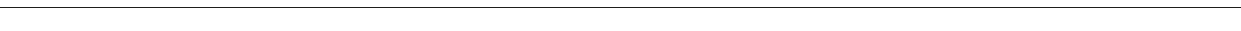
Fig. 3 Schwann cell morphology during early regeneration is disrupted in lrp4 mutants. a Pre-transection 5 dpf, GFP-labeled sibling nerve stained with anti- Sox10 antibody labeling Schwann cell nuclei (magenta). Yellow arrowheads mark Schwann cell nuclei; scale bar 10 µ m. b Sibling nerve 48 hpt labeled with GFP and stained with anti-Sox10 antibody. Yellow arrowheads mark Schwann cell nuclei. c Quanti fi cation of Schwann cell nuclei along individual nerves pre-transection and 48 hpt in siblings and lrp4 mutants. Pre-transection average Schwann cell number in siblings = 11.9 per nerve, n = 16 nerves; average Schwann cell number in lrp4 mutants = 10.78 per nerve, n = 36 nerves (two-tailed t -test p = 0.08, t = 1.743, df = 50; error bars denote mean and SD). Average Schwann cell number 48 hpt in siblings = 8.3 per nerve, n = 6 nerves; average Schwann cell number 48 hpt in lrp4 mutants = 9.3 per nerve, n = 6 nerves (two-tailed t -test p = 0.59, t = 0.5459, df = 10; error bars denote mean and SD). d – k Images from time lapse movies showing early regeneration dynamics in sibling ( d – g ) and lrp4 mutant ( h – k ) nerves. Motor axons express GFP, Schwann cells express mRFP (magenta). d Pre-transection sibling nerve, yellow box marks transection site. Schwann cell membranes (yellow arrowheads) are thin and closely associate with motor axons. White box indicates region magni fi ed in ( e – f ). Scale bar 10 µ m. e Magni fi ed image showing granular Schwann cell morphology characteristic of a denervated Schwann cell (yellow arrowheads). f Schwann cell membranes revert to smooth pre-injury morphology (yellow arrowheads). Yellow box marks region magni fi ed in (g ). g Magni fi ed image at same timepoint as ( f ), showing regenerating axons (green arrowheads) associating with fl attened Schwann cell membranes (yellow arrowheads; n = 4/4 nerves). h Pre-transection lrp4 mutant nerve, yellow box marks transection site. Schwann cell membranes (yellow arrowheads) look wild type. White box indicates region magni fi ed in ( i – j ). i Magni fi ed image showing granular Schwann cell morphology (yellow arrowheads). j Lrp4 mutant Schwann cell membranes fail to revert to smooth pre-injury morphology (yellow arrowheads). Yellow box marks region magni fi ed in ( k ). k Magni fi ed image at same timepoint as j , showing a regenerating axon (green arrowhead) associating with granular Schwann cell membranes (yellow arrowheads; n = 7/8 nerves). l Pre-transection sibling nerve; yellow box marks transection site. m – o By 48 hpt, Schwann cell membranes form two thin, continuous tracks along which regenerating axons grow; white box indicates region magni fi ed in n – o ( fi lled yellow arrowheads mark Schwann cell membranes, green arrowheads mark regenerating axons; n = 23/24 nerves). p Pre-transection lrp4 mutant nerve; yellow box marks transection site. q – s By 48 hpt, Schwann cell membranes fail to form two thin, continuous tracks and remain granular; white box in ( q ) indicates the region magni fi ed in r – s ( fi lled yellow arrowheads mark continuous Schwann cell membrane track; open yellow arrowheads mark granular membranes; green arrowhead